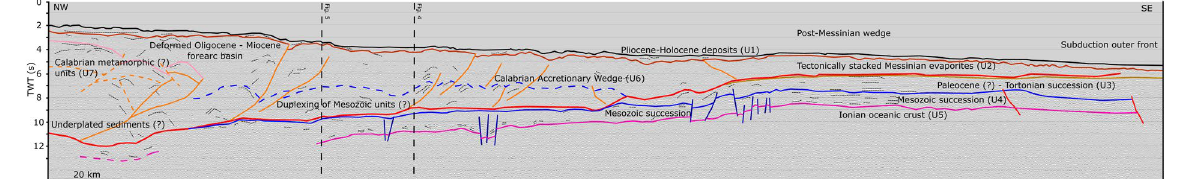
Figure 3. Structural interpretation of the CROP M2B seismic profile line drawing. Horizon colour codes as in Fig. 2. Structural elements: Orange lines: contractional structures within the accretionary wedge. Red lines: subduction interface. Dark blue lines: extensional or transtensional faults. Dashed vertical lines indicate the intersection with profile #7 (Fig. 4 and Supplementary Figure S2) and profile #14 (Fig. 5 and Supplementary Figure S3).